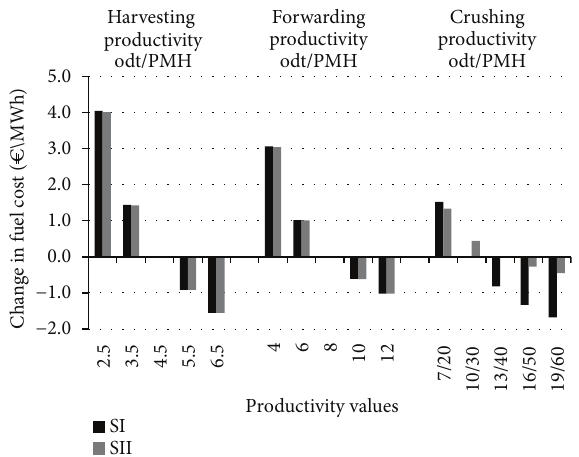
Figure 6: Influence of changes in machine productivity values on fuelcost(C/MWh)insystemsSIandSII.Whentwovaluesaregiven, the first is for system SI and the second for system SII.